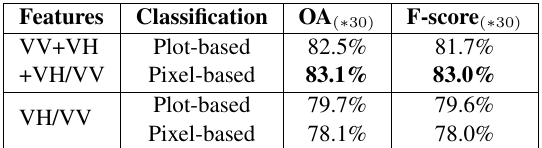
Table 5. Pixel and plot-based classification results with annual SAR backscatter